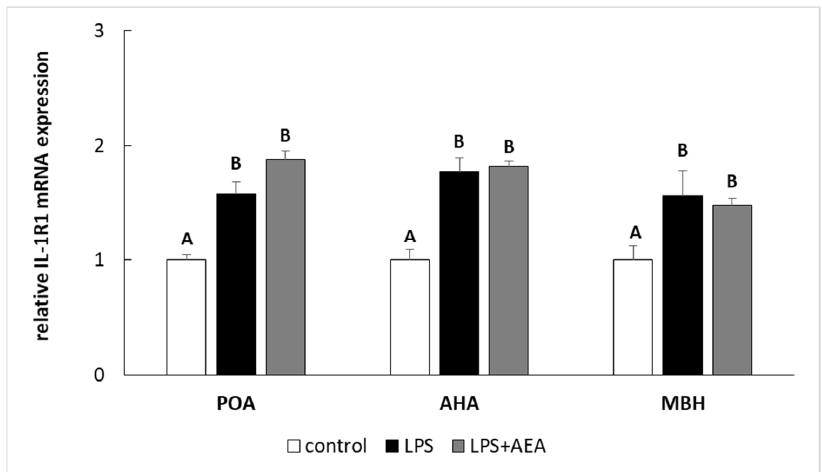
Figure 4 . The effect of intravenous (i.v.) anandamide (AEA) injection (10 μ g/kg; i.v.) and lipopoly- Figure 4. The effect of intravenous (i.v.) anandamide (AEA) injection (10 µ g/kg; i.v.) and lipopolysaccharide (LPS)-induced inflammation (400 ng/mg; i.v.) on the relative receptor type I interleukin 1 (IL-1R1) mRNA level in preoptic area (POA), anterior hypothalamus (AHA), and medial basal hypothalamus (MBH) normalized to the mean expression of three reference genes ( GAPDH , HDAC1 , ACTB —see Table 2). All data are presented as the mean value ± S.E.M. Different letters indicate significant ( p < 0.05) differences according to a one-way ANOVA followed by Fisher’s least significance test.